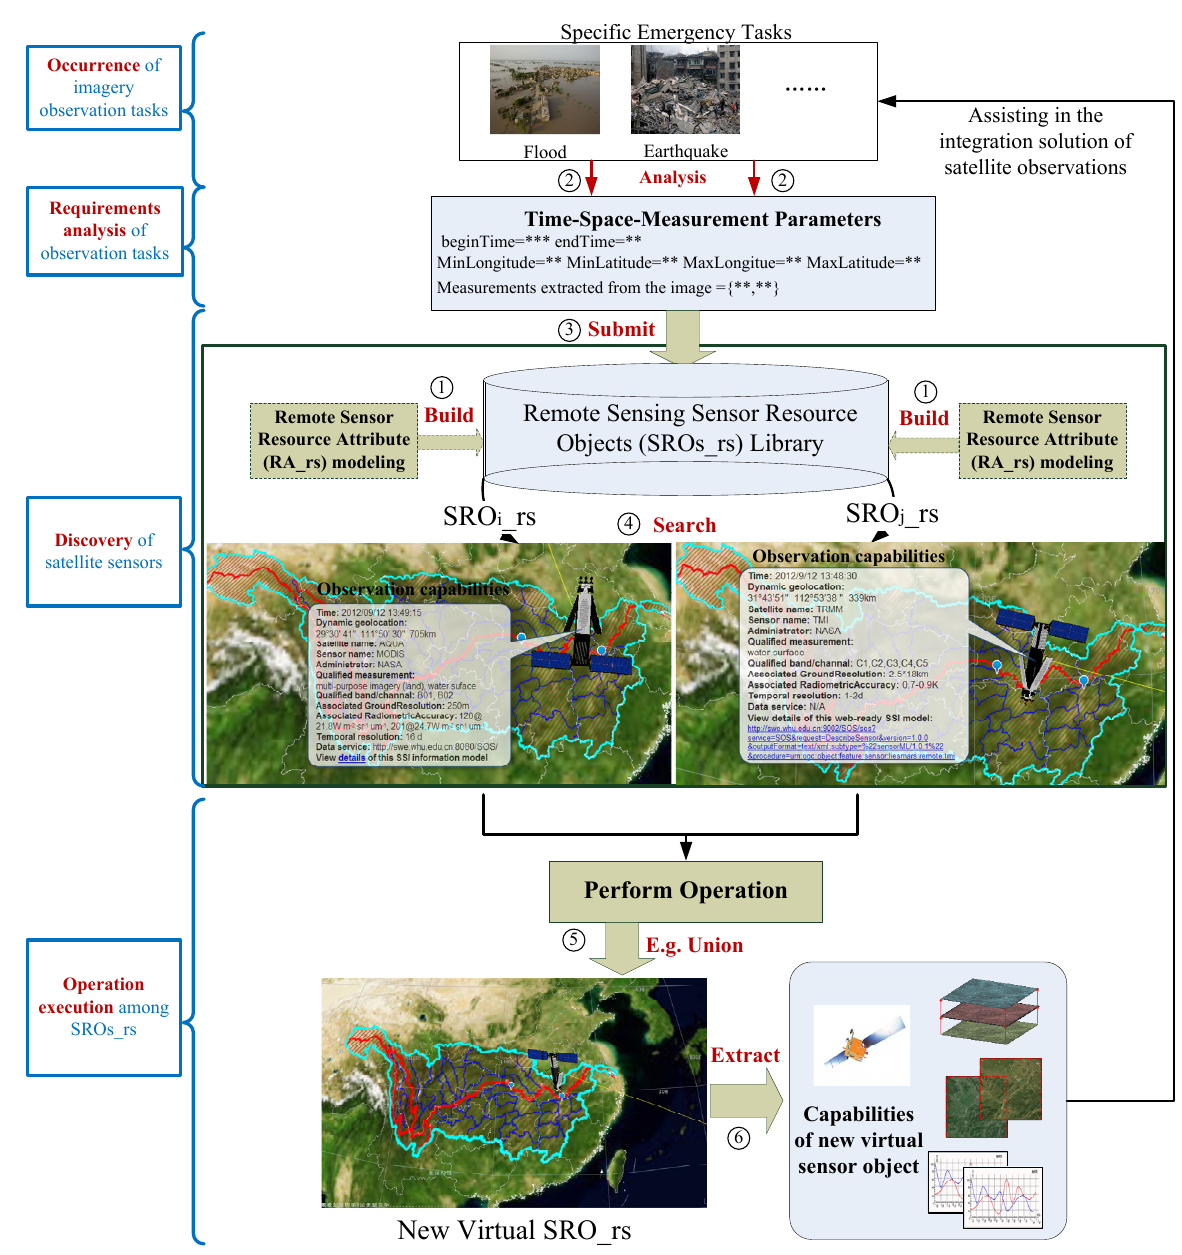
Figure 5. The stages of our proposed object model involved in the integration of satellite imagery observation (the marked numbers represent the detailed experimental